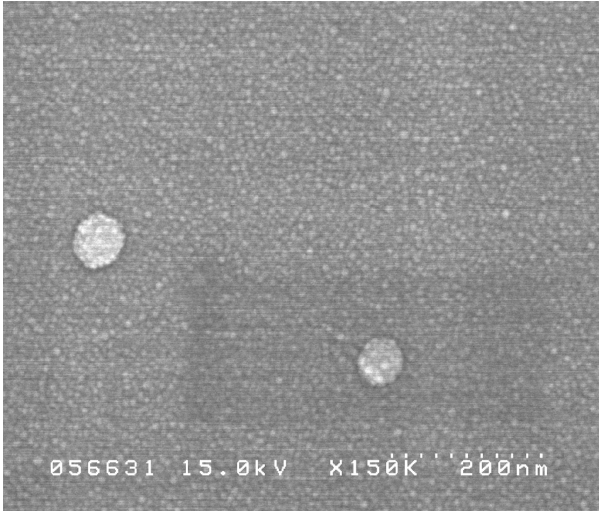
Figure 1. Field emission scanning electron microscope (FE-SEM) image of PS80 PBCA NC,